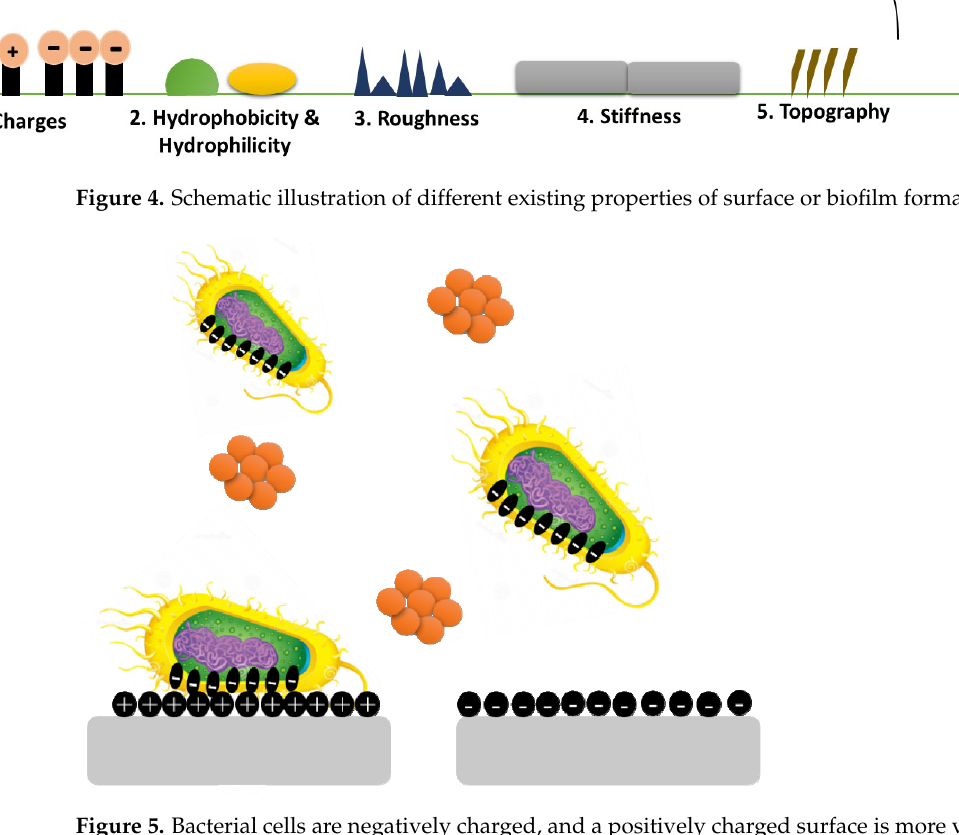
Figure 5. Bacterial cells are negatively charged, and a positively charged surface is more vulnerable to bacterial adherence than a negatively charged